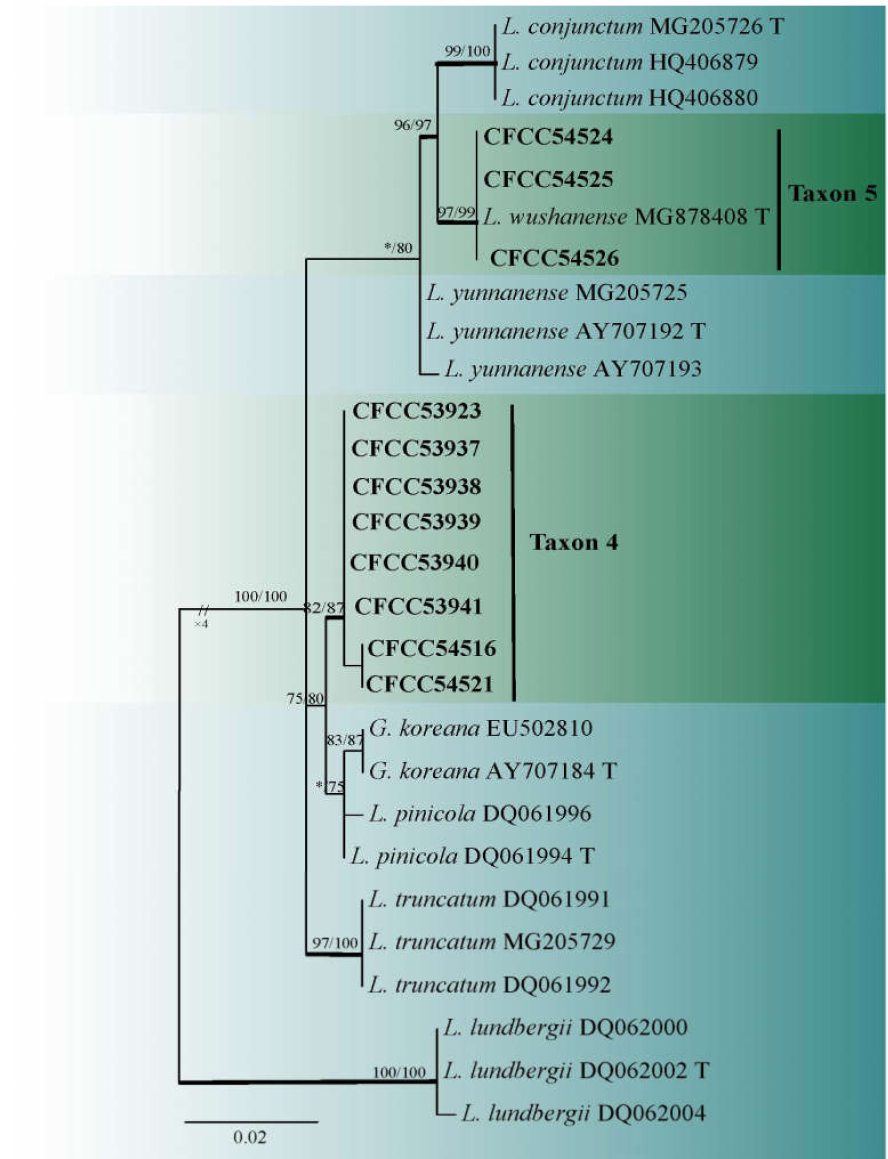
Figure 5. ML tree of L. lundbergii complex (Taxa 4 and 5) generated from the TUB2 sequence data. Novel sequences obtained in this study are presented in bold typeface. Bold branches indicate posterior probability values ≥ 0.9. Bootstrap values ≥ 70% for ML and MP are indicated above branches. Bootstrap values < 70% are indicated by *. Strains representing ex-type sequences are marked with